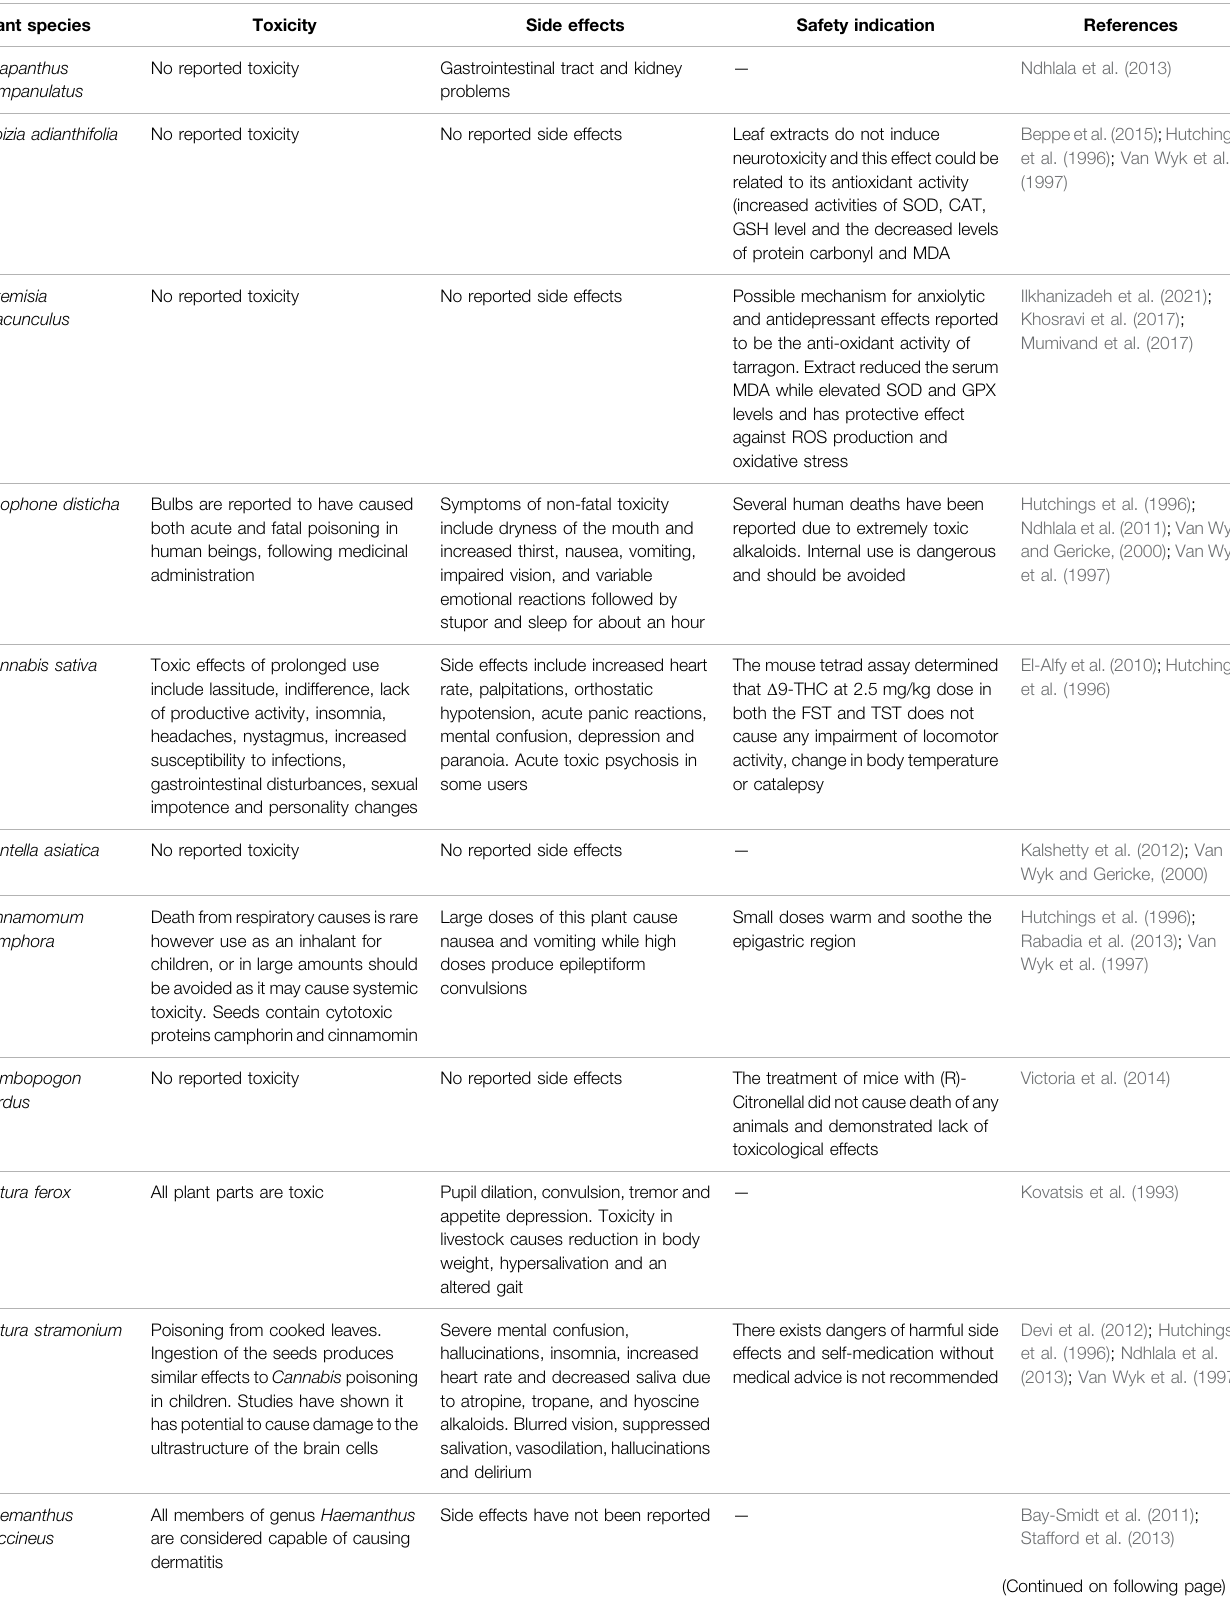
TABLE 6 | Toxicity, side effects and safety indication of South African medicinal plants used traditionally to manage depression and related